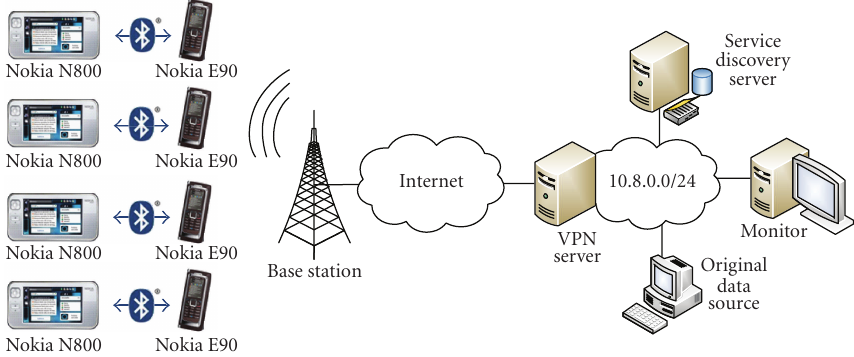
Figure 12: Test setup for evaluating the operation of the system in the mobile environment.